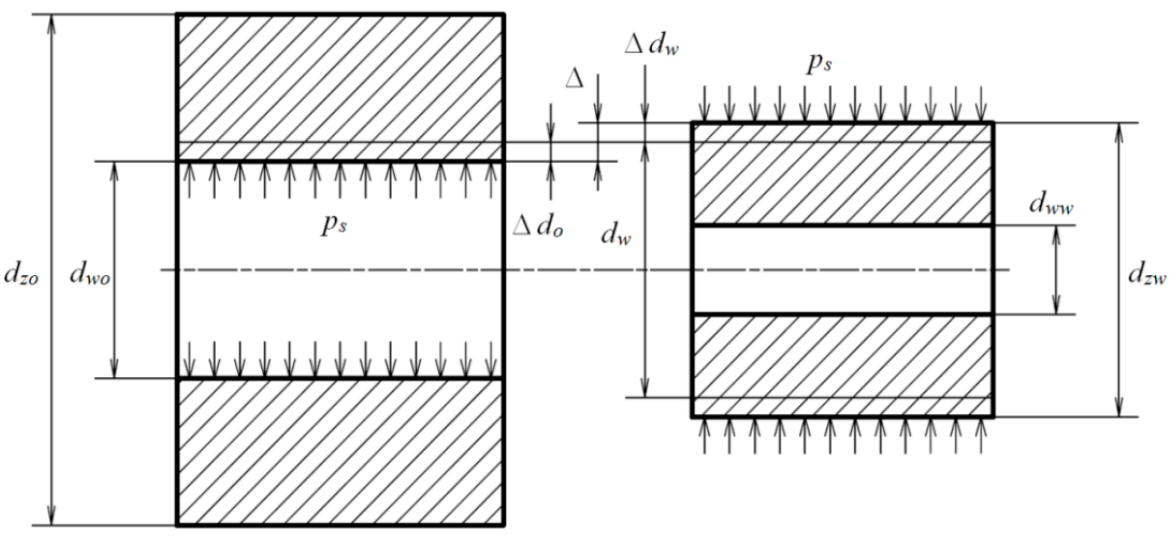
Figure 1. The idea of the interference-fit joint.